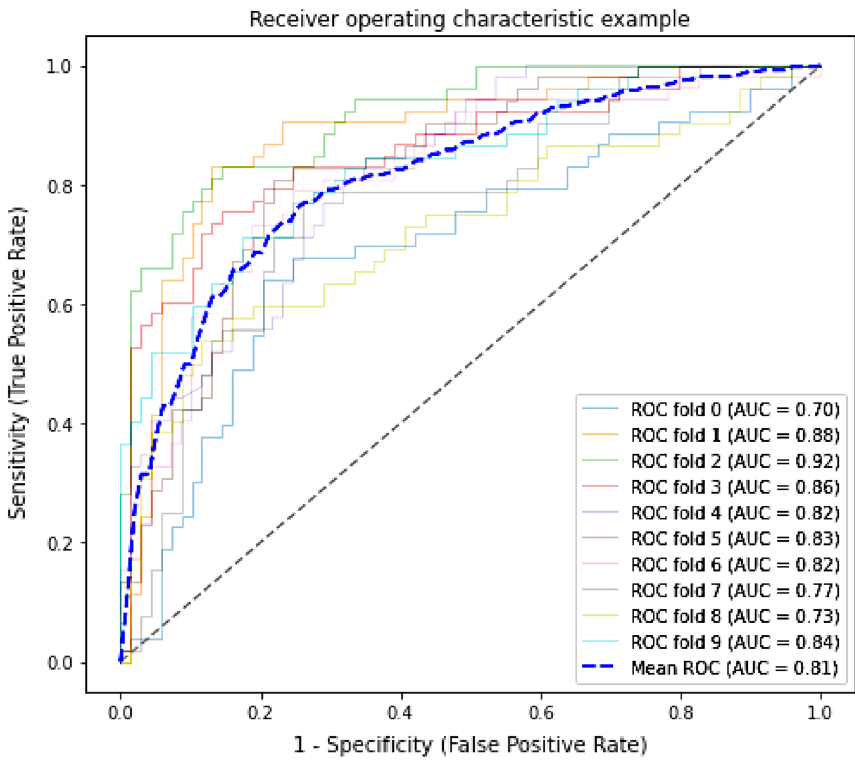
Figure 2. ROC curve for SVM on tenfold cross validation.